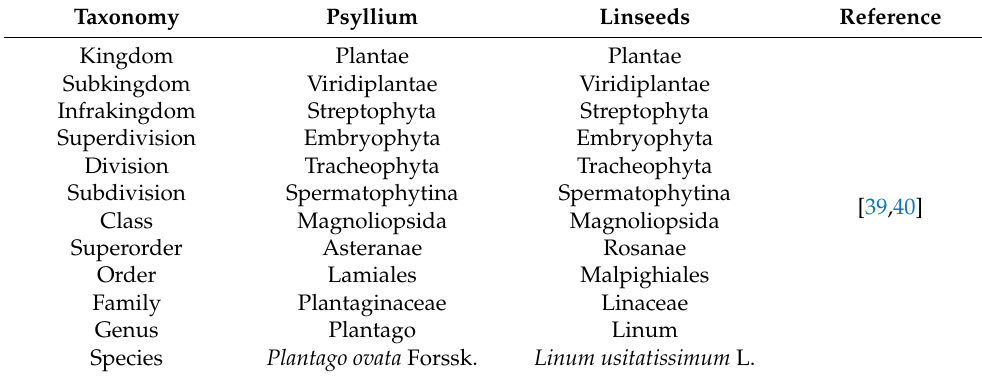
Table 1. Taxonomy of psyllium and linseeds.